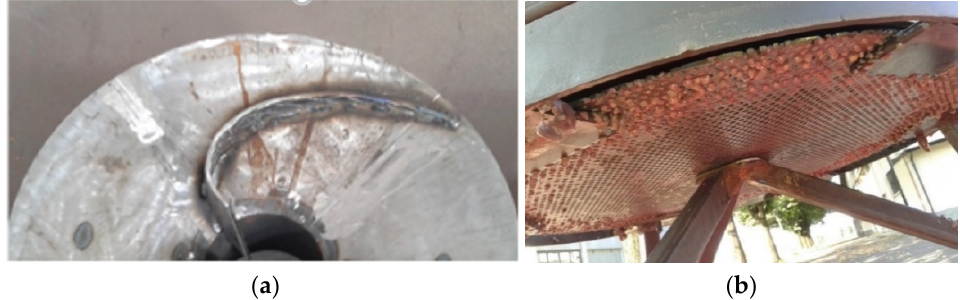
Figure 3. First prototype realisation: ( a ) working chamber with 3 spiral blades; ( b ) extrusion of pitted olive pulp.